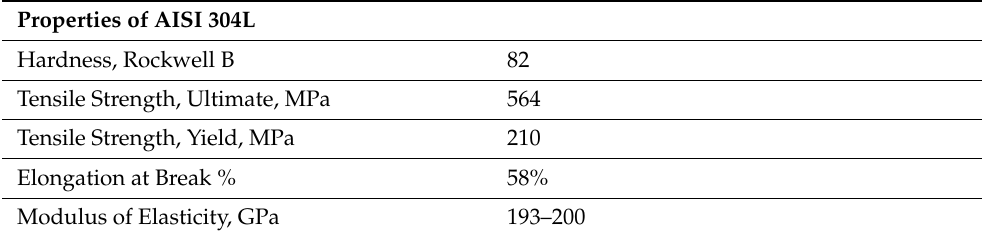
Table 2. Mechanical Properties of AISI 304L